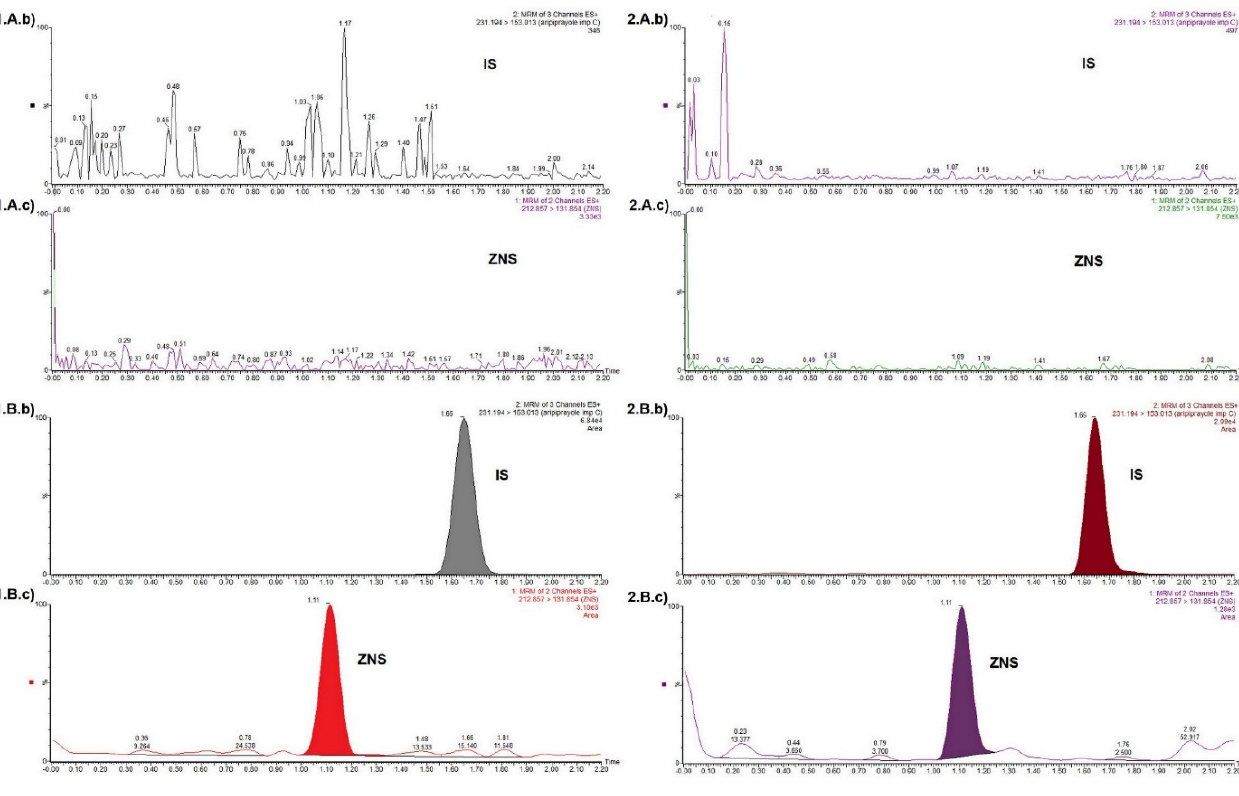
Figure 2. MRM chromatogram of the ( A ) . blank matrices, as well as chromatogram of ( b ) IS and ( c ) ZNS at ( B ) . LLOQ levels for the 1. DPS and 2. DBS. Table 2. Important parameters of linear weighted regression